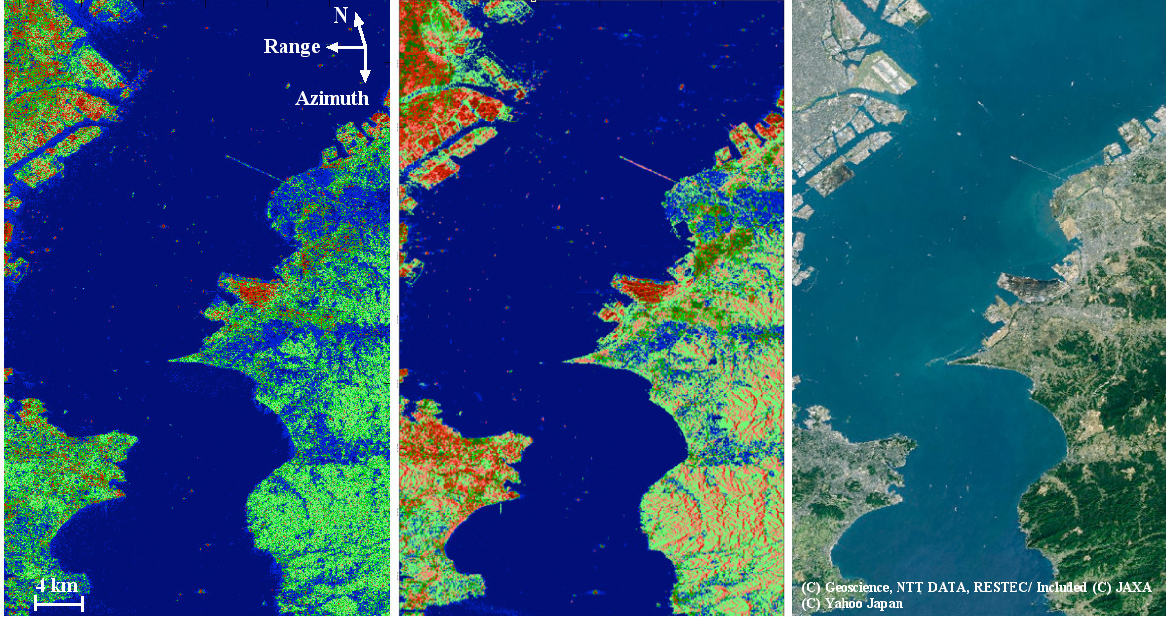
Figure 17. A classified image of the ALOS-PALSAR image of Tokyo Bay using the H/ α classifier ( left ), a classified image with the Whishart classifier of 5 iterations ( middle ), and the reference optical image ( right ). The image size is approximately 44 × 28 km in azimuth and range directions respectively with scene center at (N: 35.35 ◦ , E: 139.82 ◦